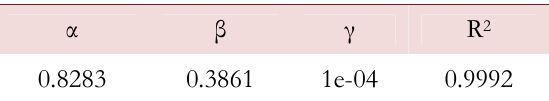
Table 4: Model parameters values (KDP_1 specimen).